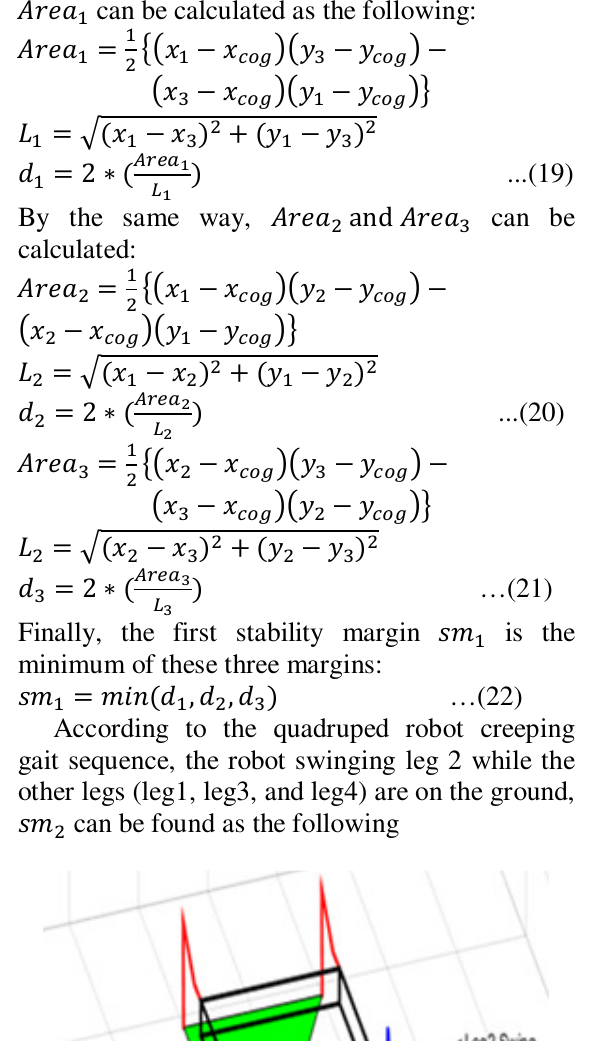
Fig. 8. Quadruped robot when leg4 is swinging (a) quadruped robot (b) Quadruped support triangle